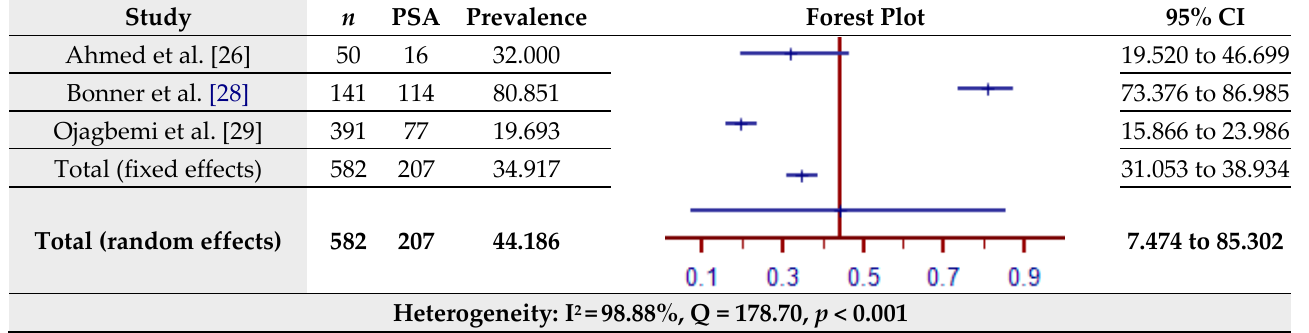
Figure 9. Prevalence estimates of Post-Stroke Anxiety (PSA) assessed by the Hospital Anxiety and Depression Scale (HADS).